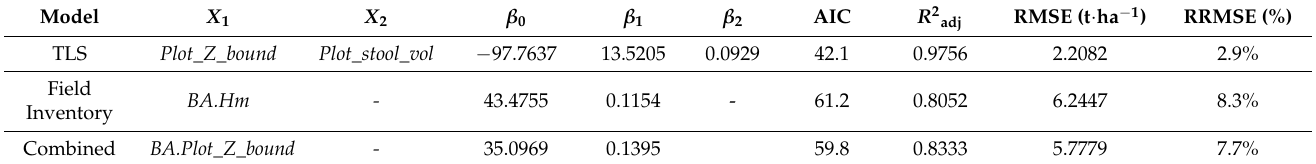
Table 6. Parameter estimates and goodness-of-fit statistics for the three fitted models (Equation (2)) for total